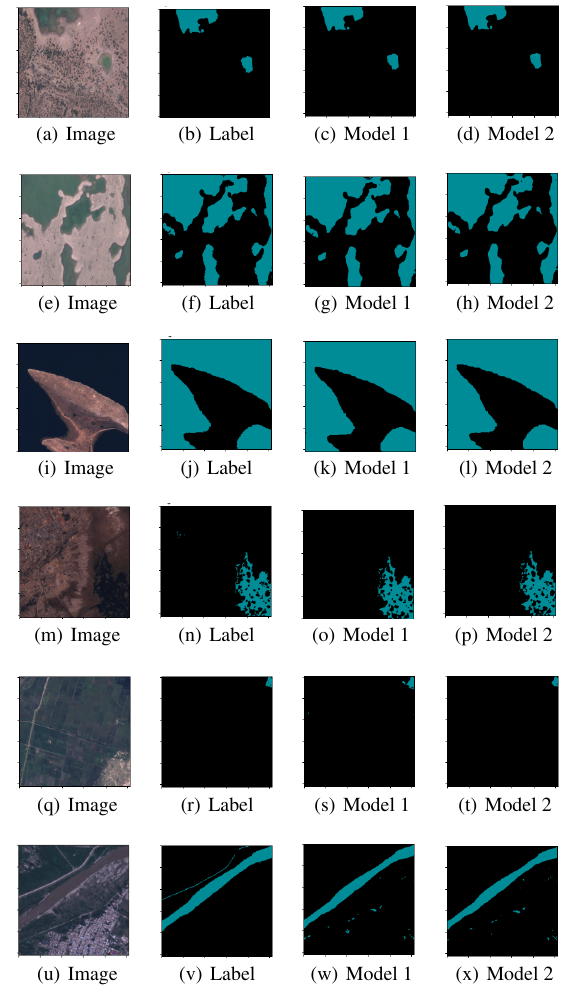
Figure 2. Example image patch (a), (e), (i), (m), (q), (u), ground-truth label (b), (f), (j), (n), (r), (v), predictions of the model 1 (c), (g), (k), (o), (s), (w), and predicitions of the model 2 (d), (h), (l), (p), (t),